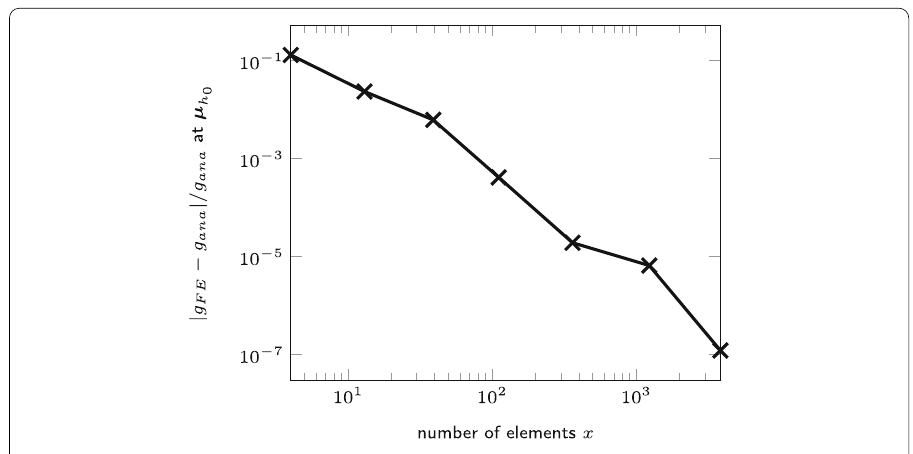
) relative to the analytic value g ana ( μ h 0